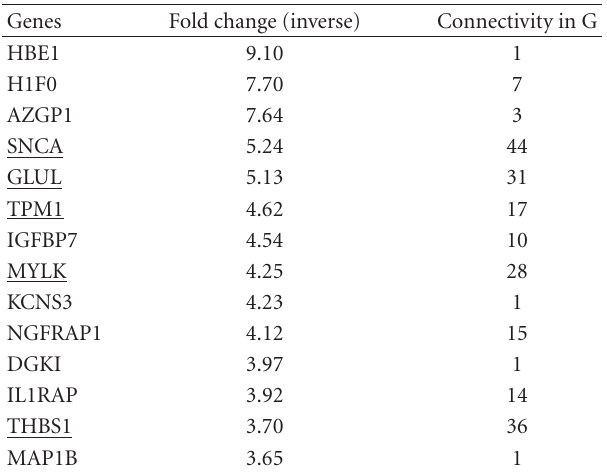
Table 2: The high ranking 14 downregulated genes. For each gene in the list, the connectivity in the protein interaction network G is given. The 5 hub nodes among the ranked down regulated genes are